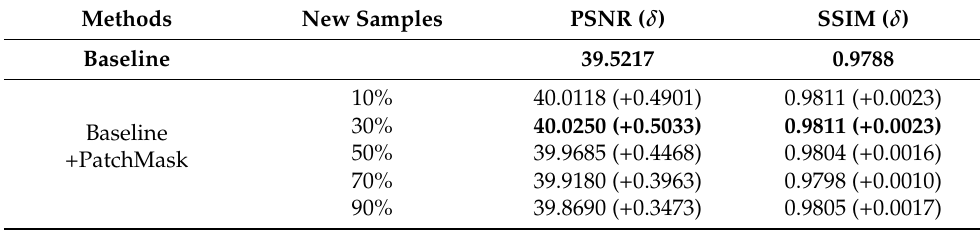
Figure 15. The effect of the number of new samples on network performance. Table 4. The impact of adding new samples generated through DA to the original dataset. For the accuracy of the experiment, our baseline here still used the QRNN3D network and ICVL dataset, and the other configurations kept the same. Best scores are highlighted.